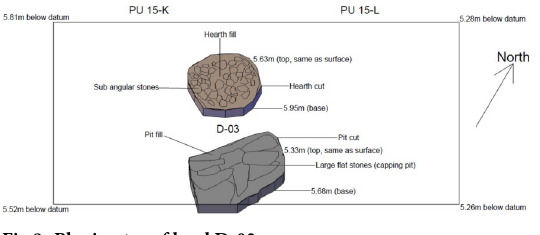
Fig 9. Planimetry of level